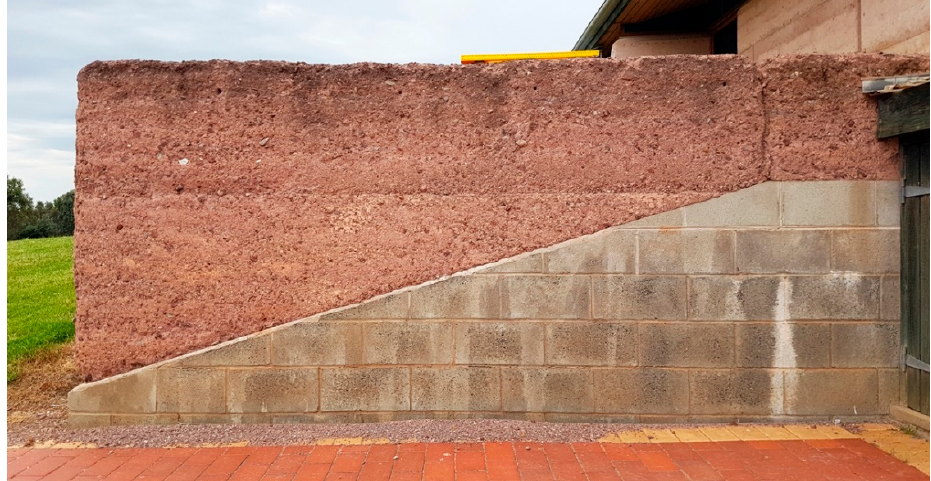
Figure 8. Wall 1 seen from the west. Note the accumulation of eroded debris at the base of the wall.